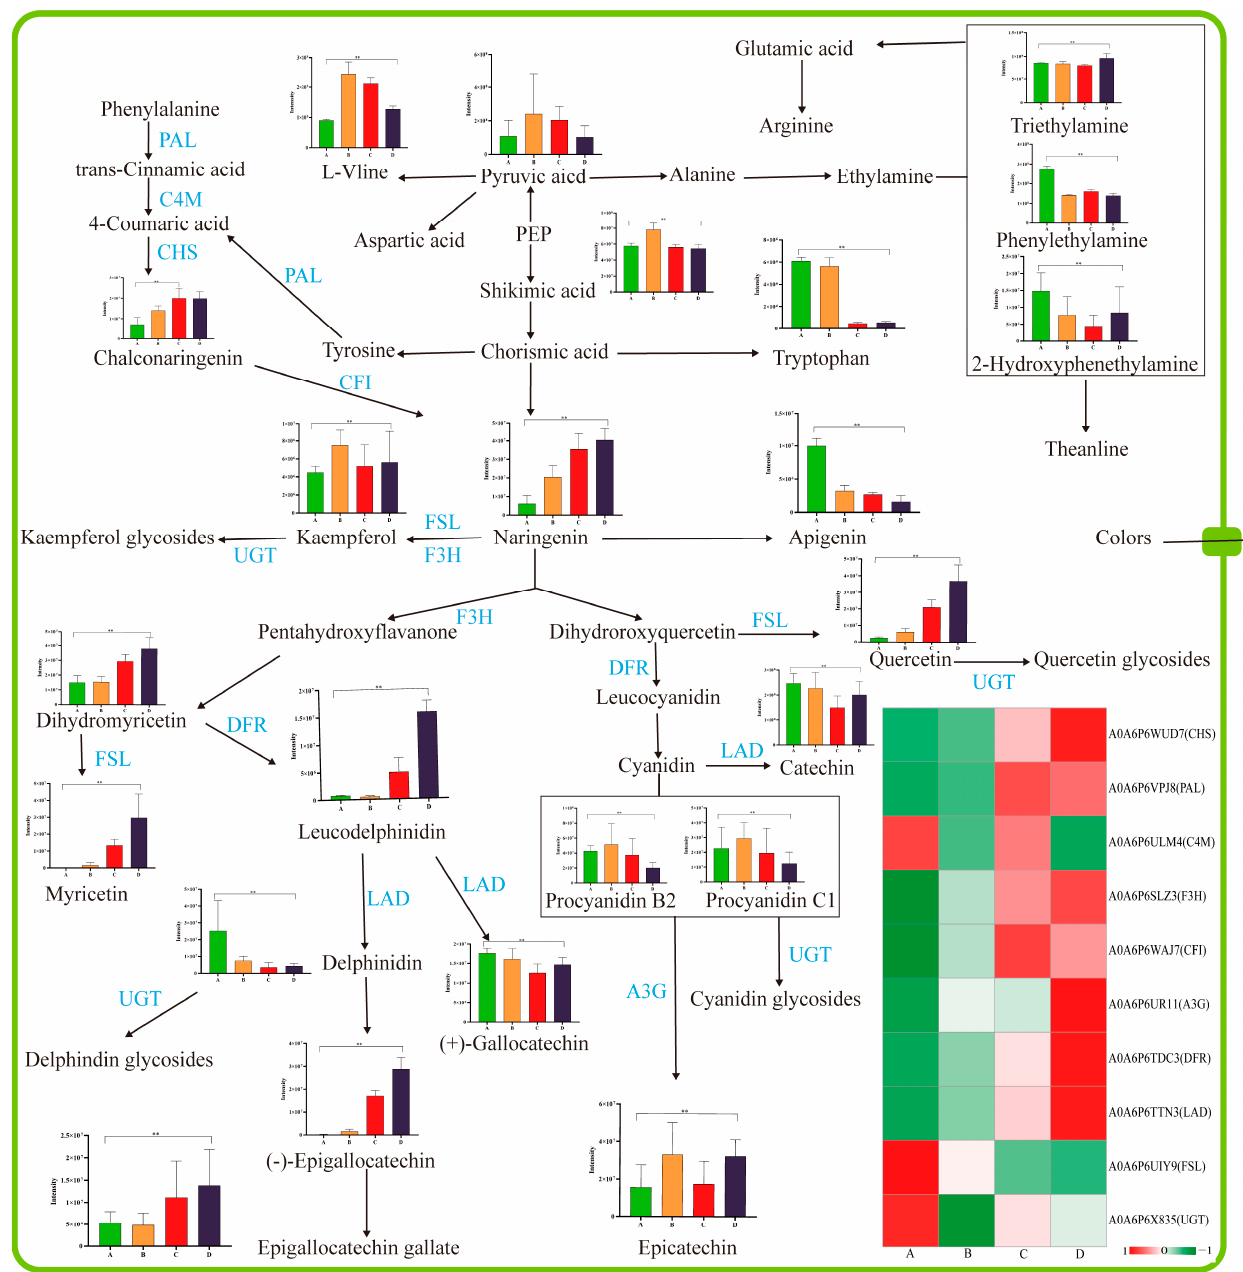
Figure 6. Diagram of phenylpropanoids and flavonoids biosynthesis pathways in the coffee cherries at different maturity stages. The ripening progression of protein expression from A to D is indicated in four box strings. “**” represents the significant differences ( p < 0.01). CHS, chalcone synthase; PAL, phenylalanine ammonia-lyase; C4M, trans cinnamate 4-monooxygenase; F3H, flavanone 3-hydroxylase; CFI, chalcone flavanone isomerase; A3G, anthocyanidin 3-O-glucosyltransferase; DFR, dihydroflavonol 4-reductase; LAD, leucoanthocyanidin dioxygenase; FSL, flavonol